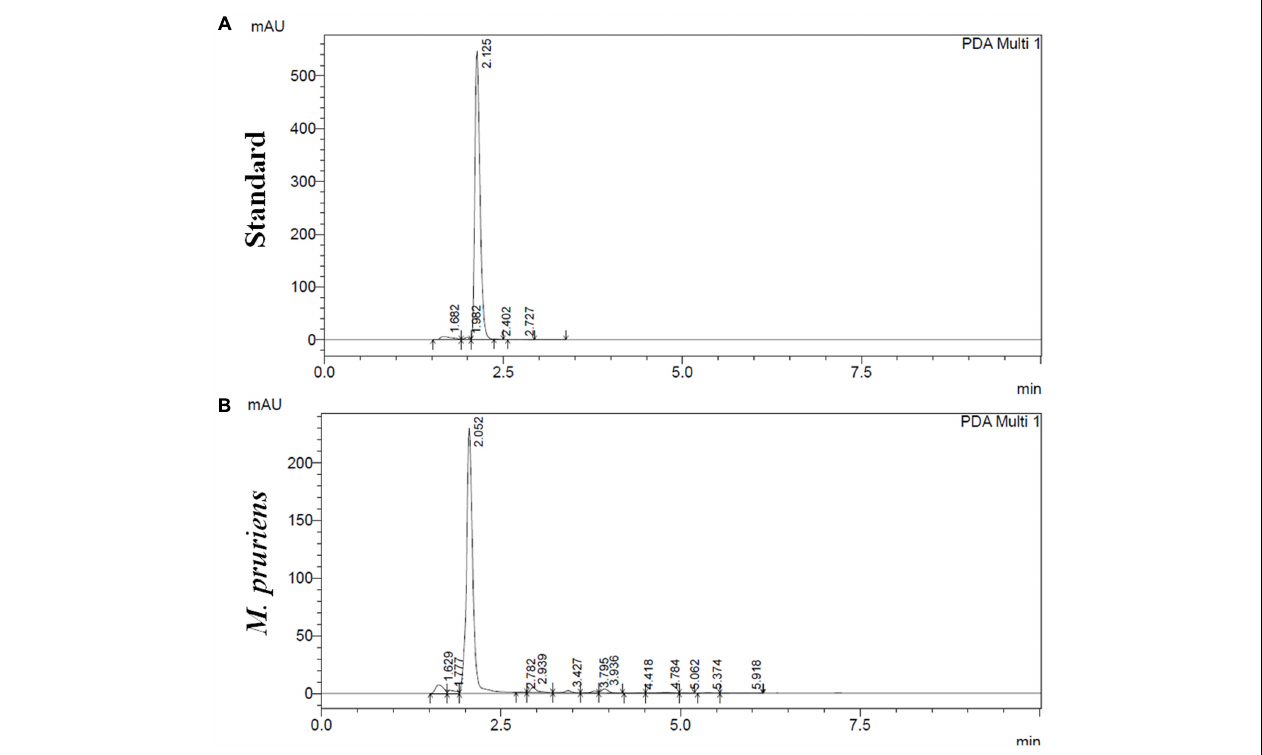
FIGURE 1 | High performance liquid chromatography (HPLC) analysis of M. pruriens seeds for L -DOPA. HPLC profile of standard L -DOPA (A) . HPLC profile of M. pruriens seed extract (B) .